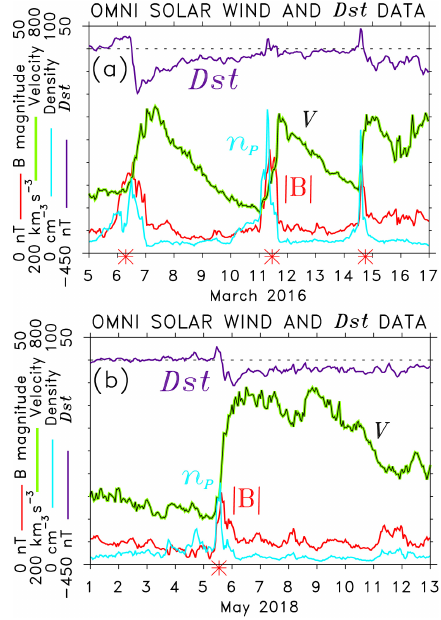
Figure 1. The hourly OMNI solar wind velocity, V , magnetic field, B , proton density, n p , and the Dst index for 2 periods in (a) 2016 and (b) 2018. Major HSS/CIRs (red asterisks) are